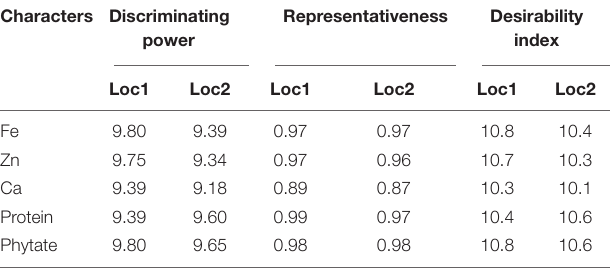
TABLE 5 | Standardized test location evaluation parameters. Characters Discriminating power